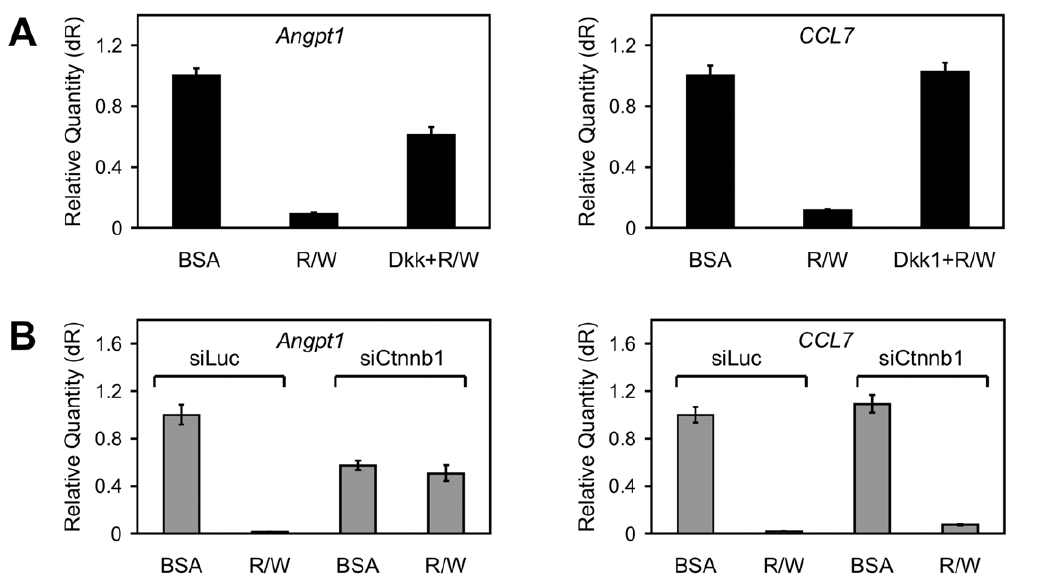
Figure 7. Contrasting effects of Dkk1 and b -catenin knockdown on representative genes down-regulated by Rspo2 and Wnt3a. ( A ) Quantitative RT-PCR analysis of Angpt1 and CCL7 expression following 24 h incubation with BSA or Rspo2 (10 ng/ml) plus Wnt3a (100 ng/ml), with or without Dkk1 (1 m g/ml) pre-treatment. ( B ) Quantitative RT-PCR analysis of Angpt1 and CCL7 expression following 24 h incubation with BSA or Rspo2 (10 ng/ml) plus Wnt3a (100 ng/ml) after pre-treatment with siLuc vs. siCtnnb1. Results in (A) and (B) are means + / 2 S.D. of triplicate measurements from one of three representative experiments performed simultaneously with experiments illustrated in Figures 4 and 5.